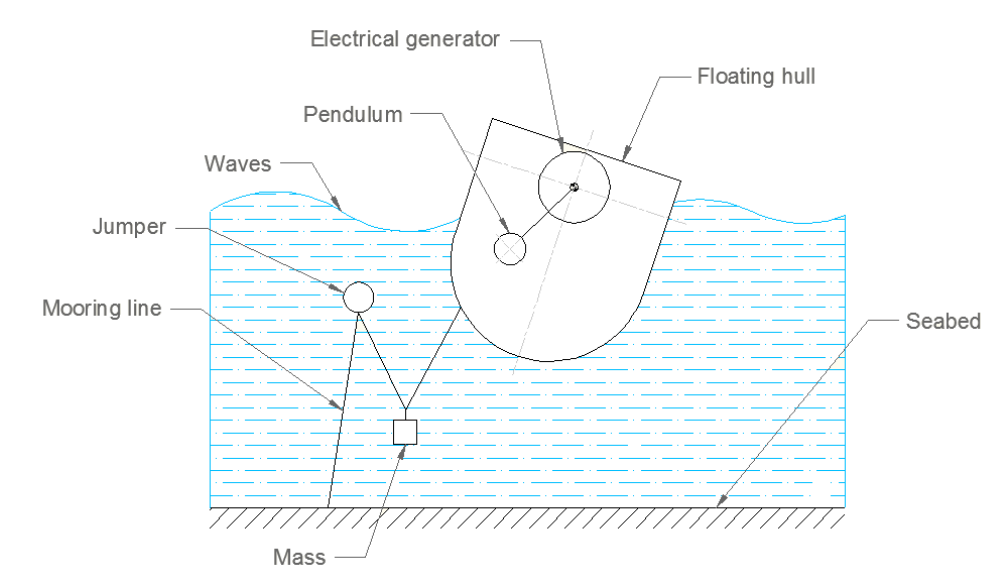
Figure 1. Schematic of the PeWEC working principle. Incoming waves excite the floating hull in pitch, transferring energy to the oscillation of an inner pendulum, whose motion is damped by a PTO. Three 3-segment mooring system, composed of a jumper and a clump-weight, keeps the system in